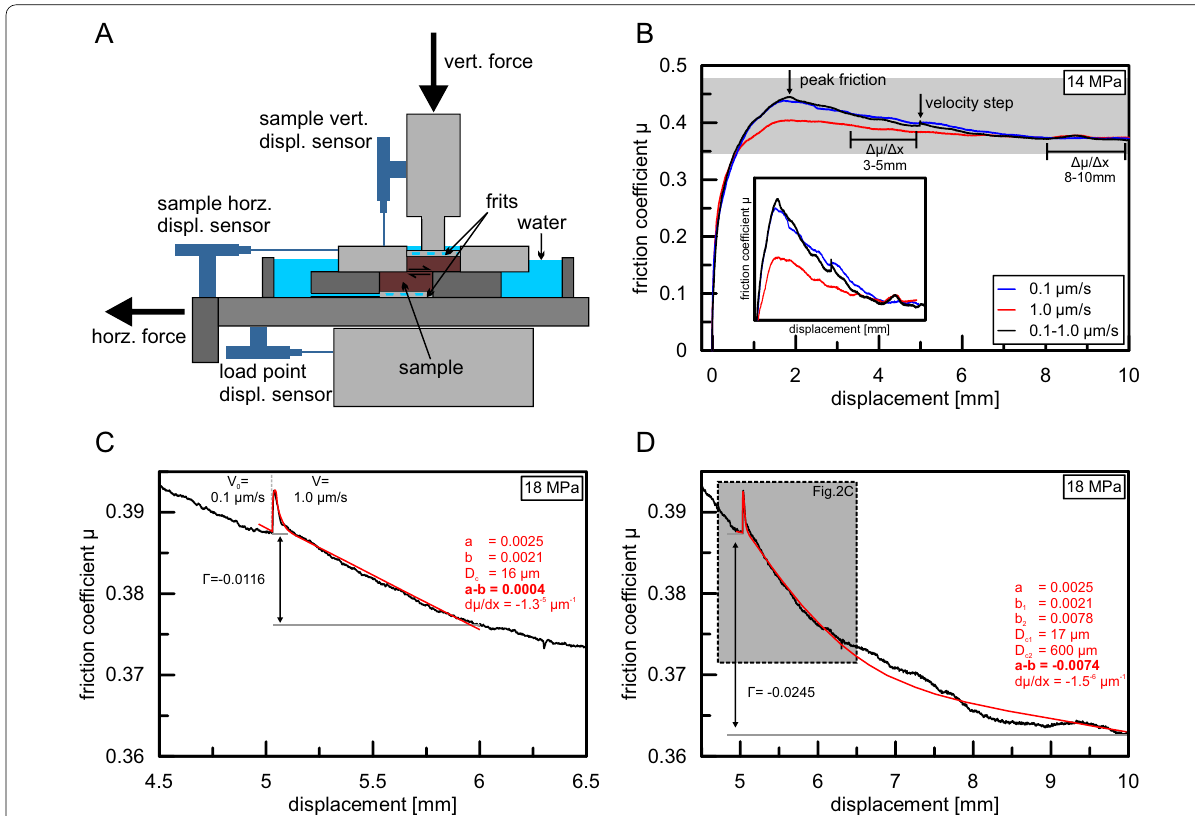
Fig. 2 Shear device and experimental data example. A Schematic diagram of the shear device used in this study. The lower sample cell holder (in darker grey) moves to the left as shearing is induced in the sample. B Example data from one set of experiments at conducted at 14 MPa effective normal stress, gray background indicates data shown in the inset. C Friction data during a velocity step overlain by modeled an inverse model over 1 mm, net change in frictional strength is shown as Γ . D Friction data during a velocity step modeled over 5 mm, net change in frictional strength again shown as Γ . VS: velocity